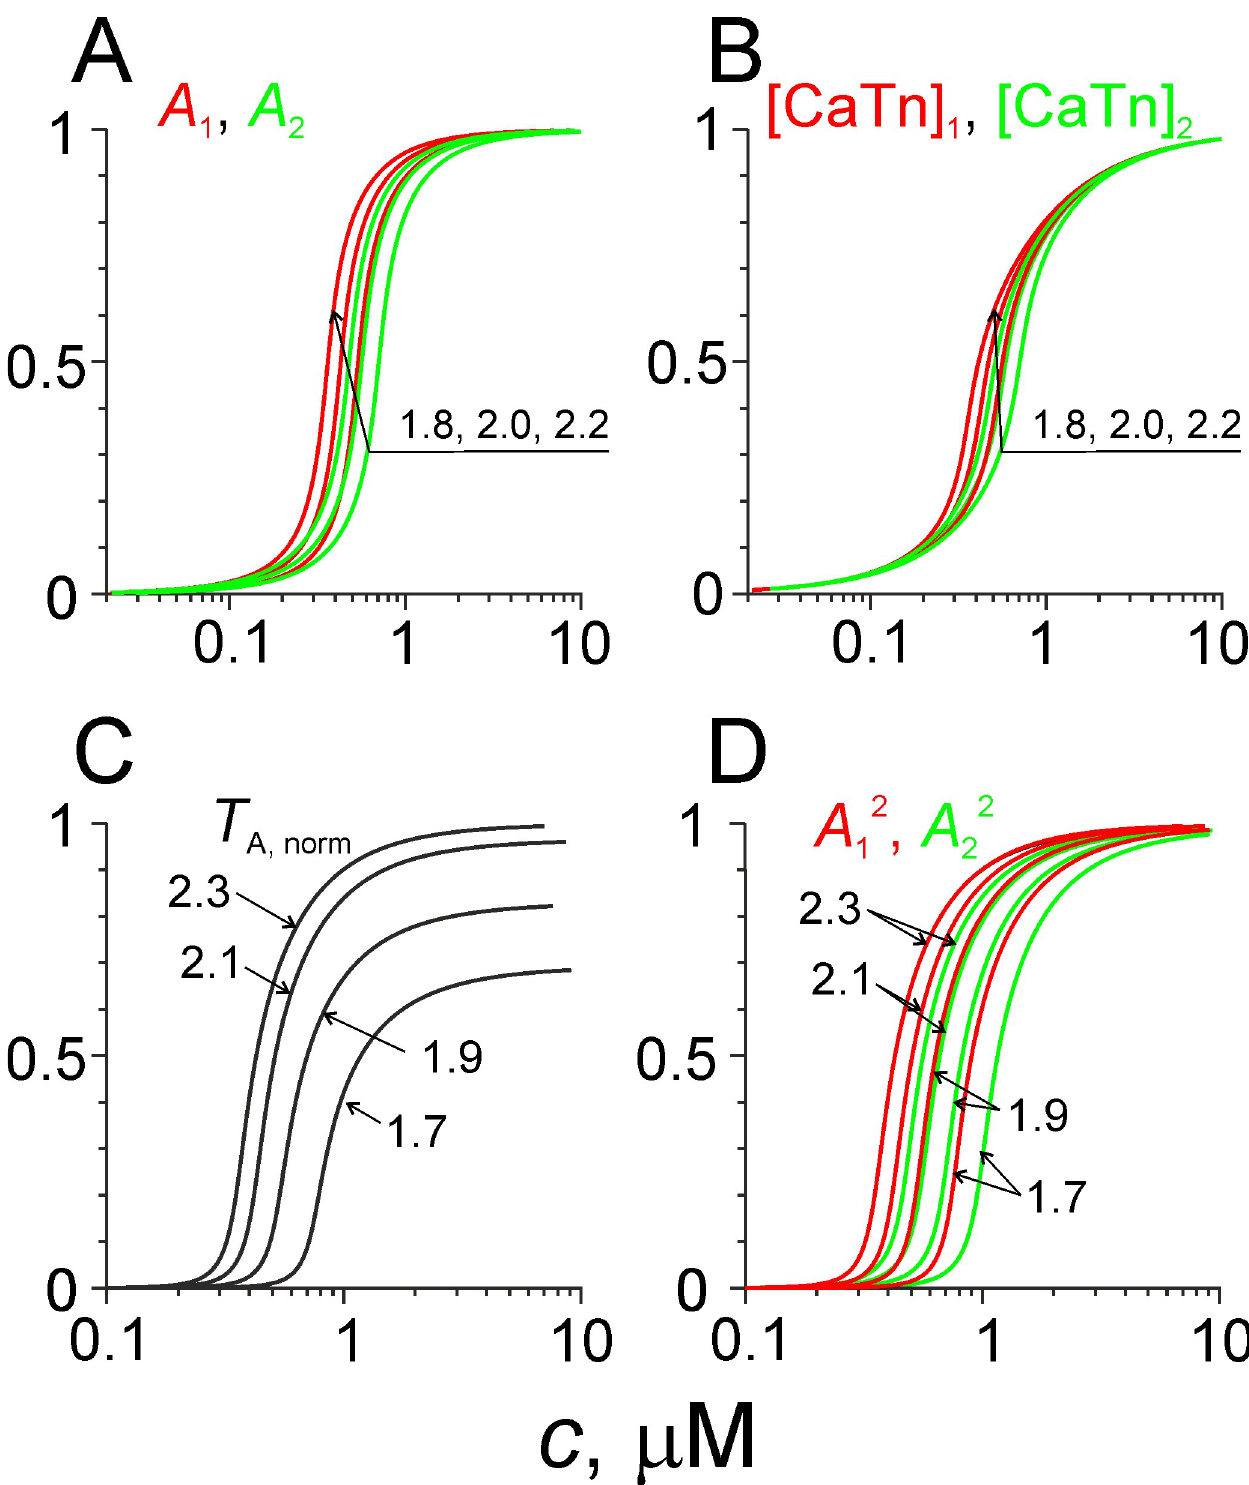
Fig 1. Simulation of steady-state muscle contractions. Calculated Ca 2+ -dependencies of A 1 and A 2 (red and green, respectively, A), normalised CaTn concentration in the overlap (red) and non-overlap (green) zones of a sarcomere (B), normalized active tension (C) and A 2 length are shown. The length values are shown next to the curves in μ